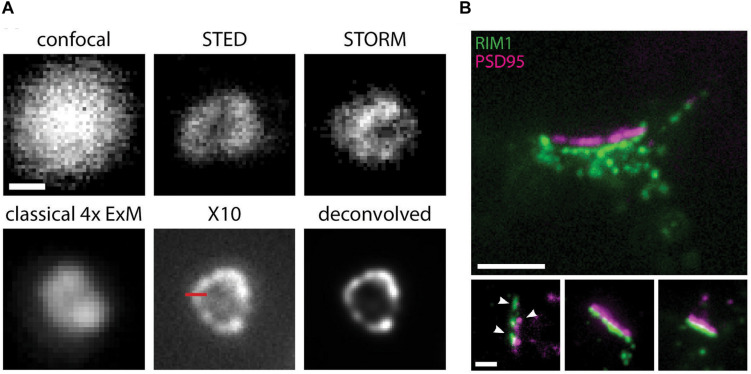
X10 expansion microscopy can achieve super resolved images on a conventional microscope. (A) Immunostaining for the peroxisome membrane protein Pmp70 in neurons, imaged before expansion by confocal, STED, or STORM microscopy, and by standard epifluorescence microscopy after classical 4x sample expansion or X10 sample expansion. The last panel shows the X10 image after deconvolution. Scale bar, 100 nm. (B) Representative immunostaining images for postsynaptic PSD95 (magenta) and presynaptic RIM1/2 (green) proteins in cultured neurons at an expansion factor of 10.4x. Nanocolumns of aligned pre- and postsynaptic proteins are indicated by arrowheads. Scale bars: 500 nm (upper panel) and 200 nm (lower panels). Adapted, with permission from Truckenbrodt et al. (2018).